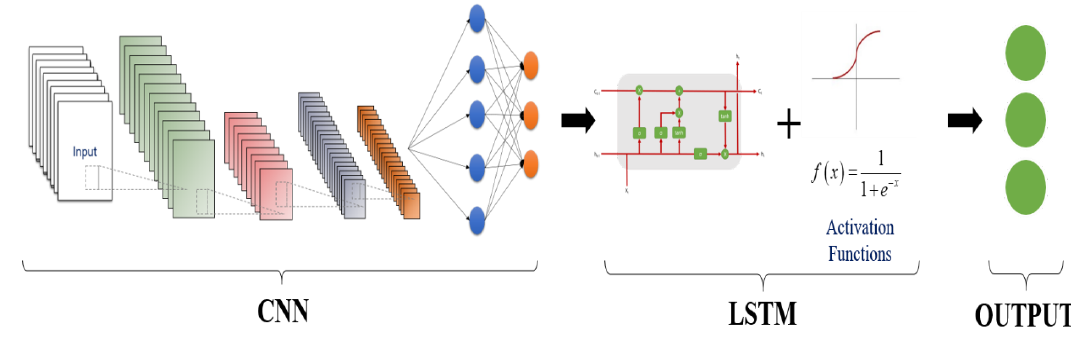
Figure 8. Illustration of convolutional neural network (CNN)–long short-term memory (LSTM) architecture.